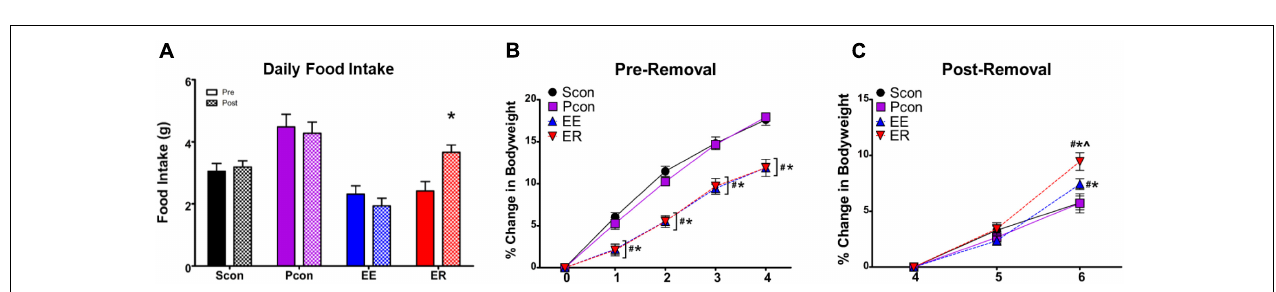
FIGURE 3 | Enrichment removal increases anhedonia in the sucrose preference test and passive coping behavior in the forced swim test. (A) ER animals have a decreased preference for sucrose on the first day of the sucrose preference test relative to PCon and Scon groups # p < 0.05 vs. Scon, ∗ p < 0.05 vs. Pcon. (B) ER females spent significantly more time immobile in the FST relative to pair housed controls (Pcon) and single housed animals (Scon) # p < 0.05 vs. Scon, ∗ p < 0.05 vs. Pcon.